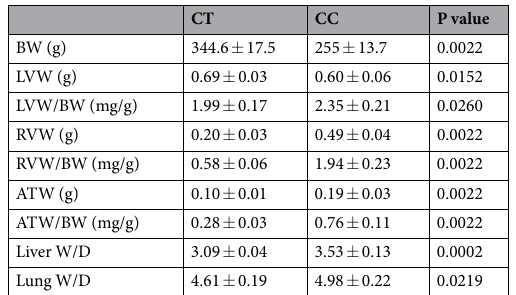
Table 1. Anatomic data of CT and CC groups. Values are mean ± SD; n: number of animals; CT: control group (n = 6); CC: cardiac cachexia group (n = 6); BW: body weight; LVW: left ventricle weight; RVW: right ventricle weight; ATW: atrium weight; W/D, wet-to-dry weight. P value of the statistical significance difference between the